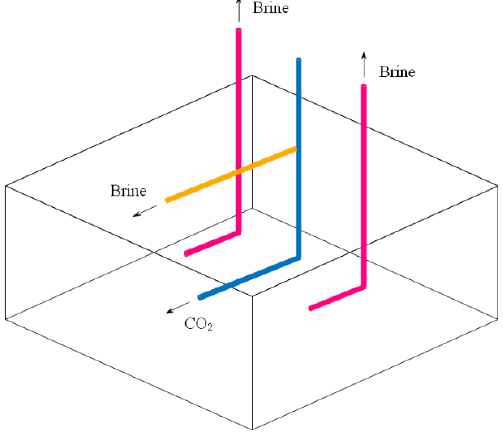
Figure 7. Engineered injection method to accelerate CO 2 dissolution and trapping (adapted from